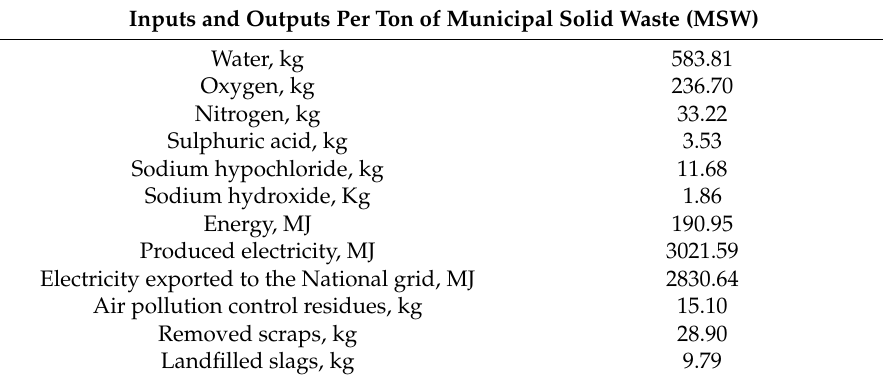
Table 2. Main lifecycle inventory for the studied system.